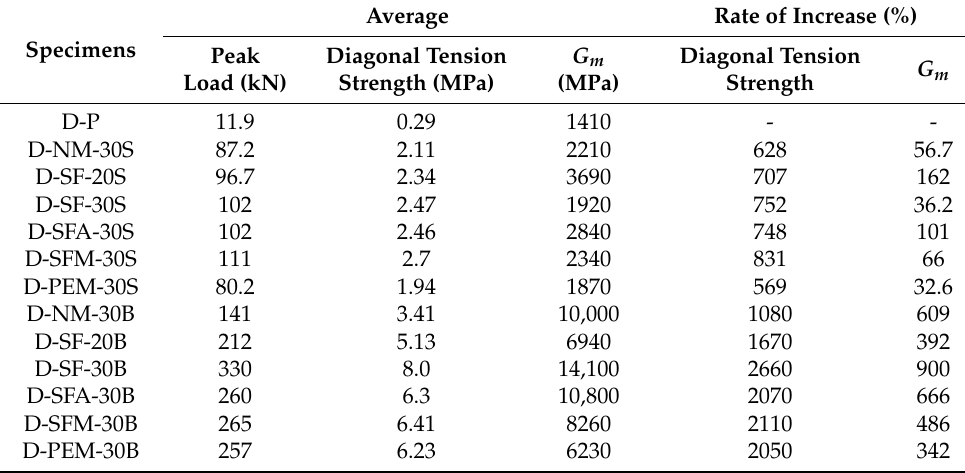
Table 5. Diagonal tension strength test